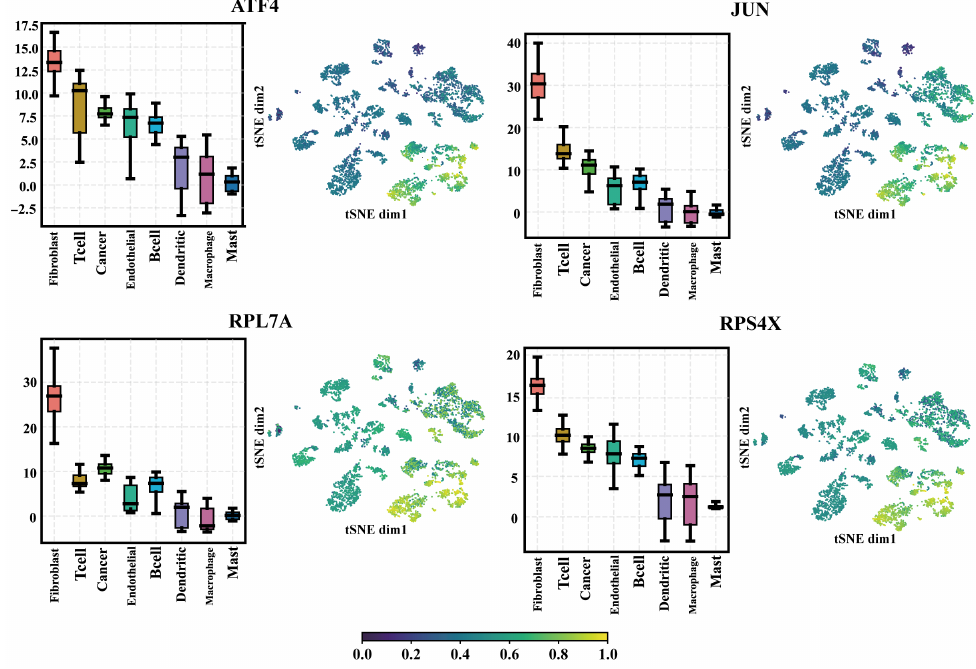
Figure 5. The regulatory weight of the different genes in the eight cells. Four regulators are presented: ATF4, JUN, RPL7A, and RPS4X. The boxplots show the weight distribution of the regulators on dif- ferent SEM matrices. The t-SNE plots represent the weight distribution of regulators on the